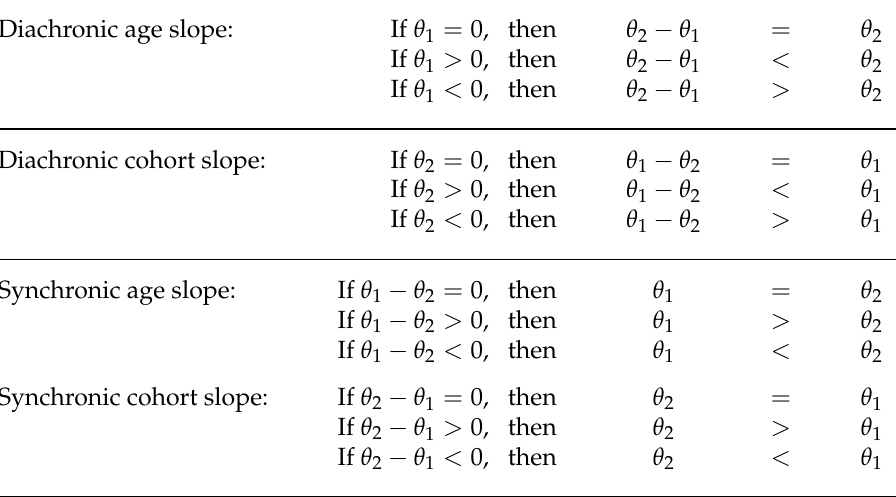
Table 2: Relationships among diachronic and synchronic